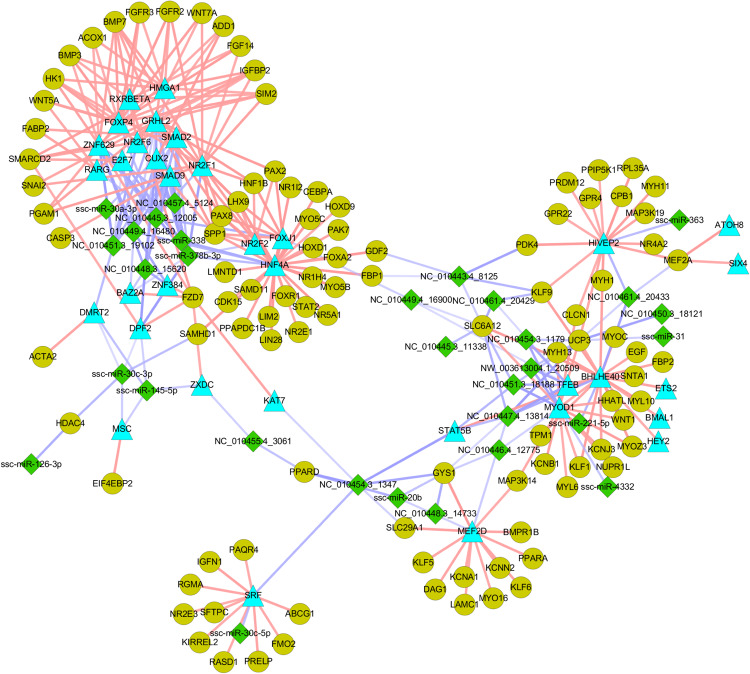
The nutrient-modulated miRNA-TF-mRNA regulatory loop associated with skeletal muscle development. Green diamonds indicate DE miRNAs identified between NE and RE group; Blue triangles indicate miRNA targeted TFs that are potentially involved in myogenesis; gray-green dots indicate potential target of the TFs that are involved in myogenesis. The miRNA-mRNA regulatory pairs were identified by using sequence-based target prediction and negative correlation of miRNA-mRNA profiles, and the targets of TFs were identified based on their regulation relationships as described in “Materials and Methods” section.